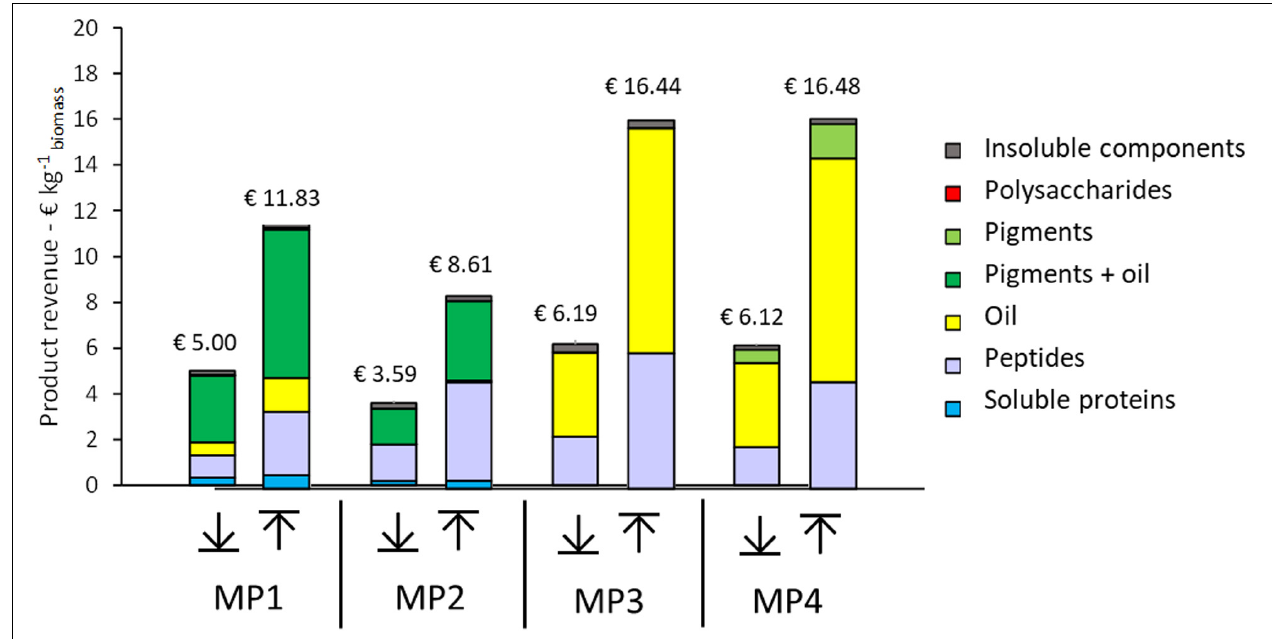
FIGURE 8 | Range of potential product revenue expressed per unit of initial biomass for each multiproduct (MP) value chain. ( ↓ ) worst case revenue estimates, ( ↑ ) best case revenue estimates.